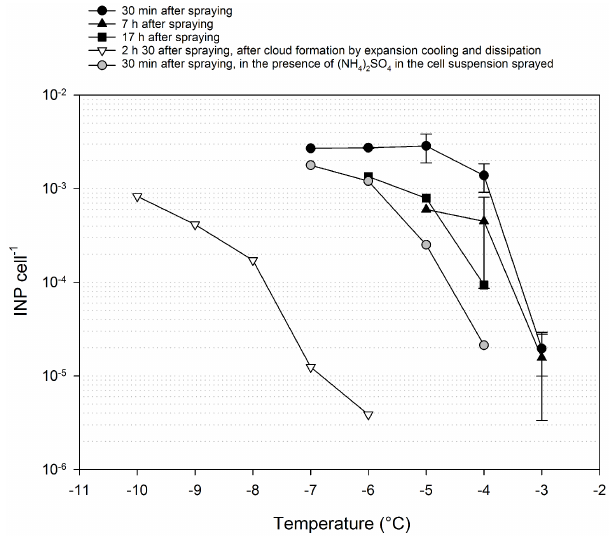
Figure 4. Cumulative frequencies of INP per airborne cell in P. sy- ringae 32b-74 within the AIDA chamber 30min, 7h and 17h after aerosolization in the absence of cloud (black symbols), 30min after aerosolization in the presence of ammonium sulfate (grey symbols), and when the pressure inside the chamber was returned to ambient after cloud formation by expansion cooling (open triangles). Error bars are standard deviations from the mean of independent experi- ments, when